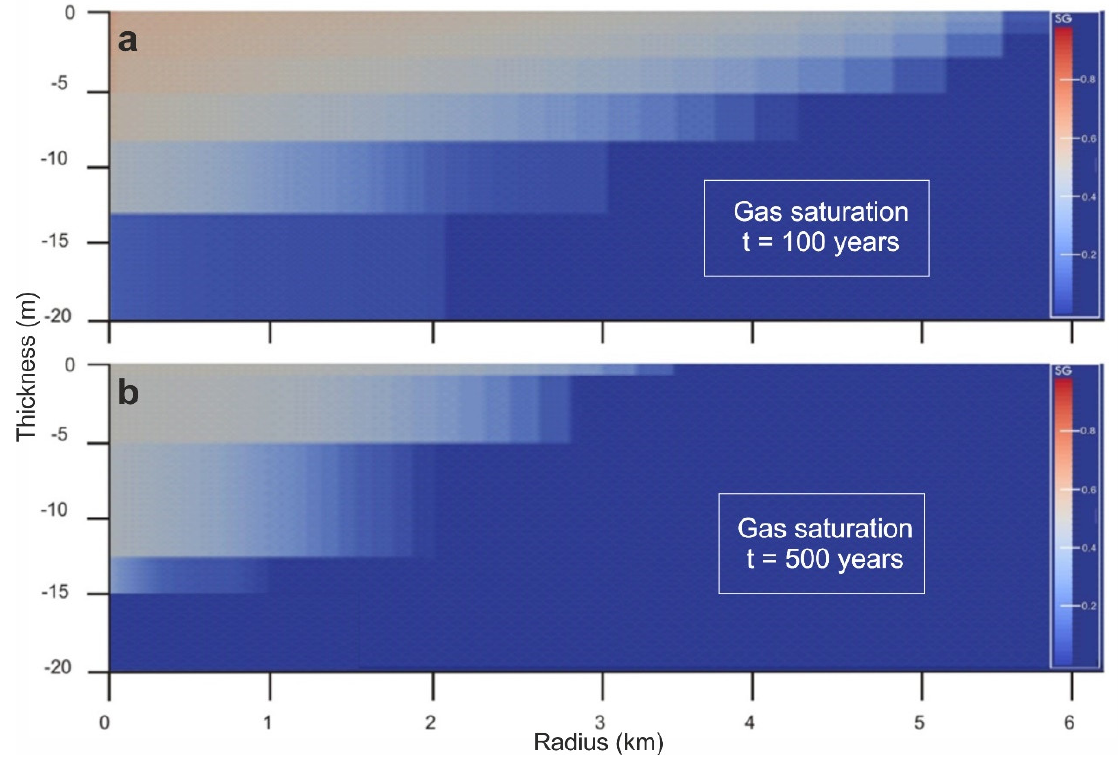
Figure 3. Saturation of the storage reservoir by CO 2 100 ( a ) and 500 ( b ) years after the injection ceased. The scale on the right shows the CO 2 fraction values in the pore environment of the reservoir.